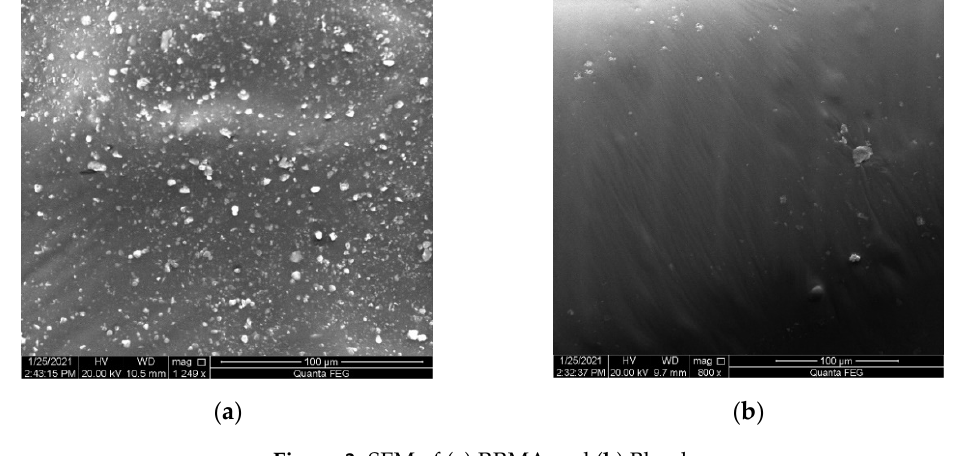
Figure 3. SEM of ( a ) RRMA and ( b ) Blend.